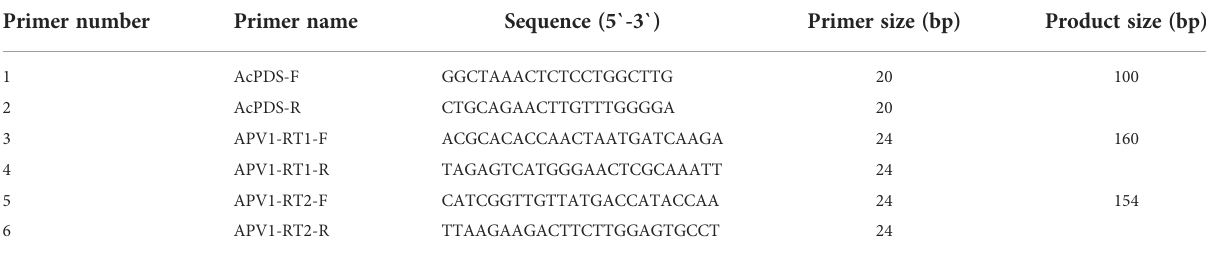
TABLE 1 List of primers used in the current